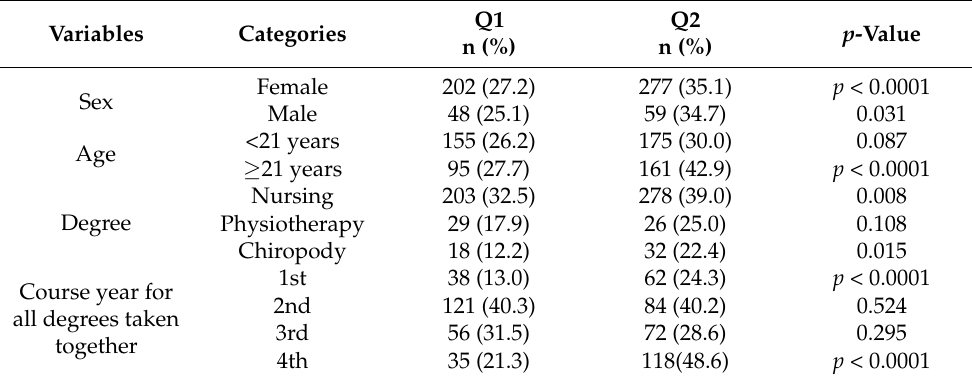
Table 2. Flu vaccination coverage by sex, age, degree and course in Q1 and